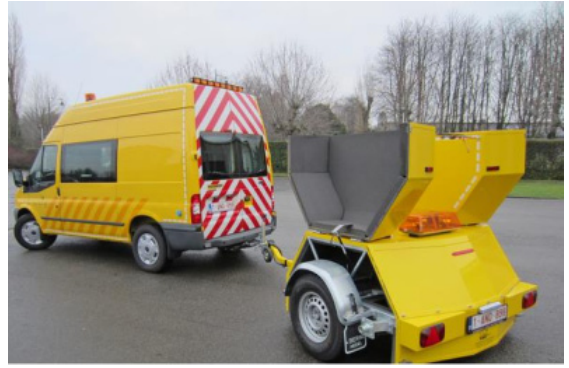
Figure 1. CPX trailer used by AWV.